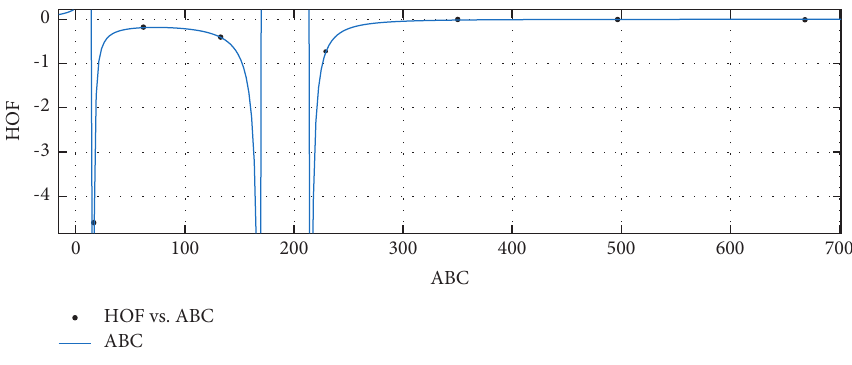
Figure 7: ABC ( x -axis) versus HoF ( y -axis).